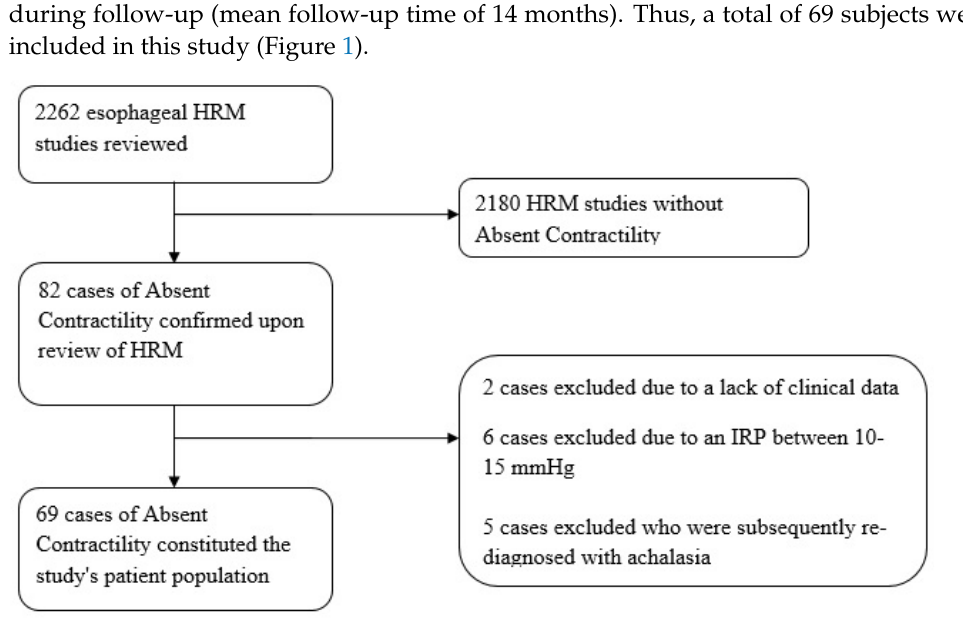
Figure 1. Flowchart of Absent Contractility patients. IRP : integrated relaxation pressure ; HRM : high ‐ resolution manometry.